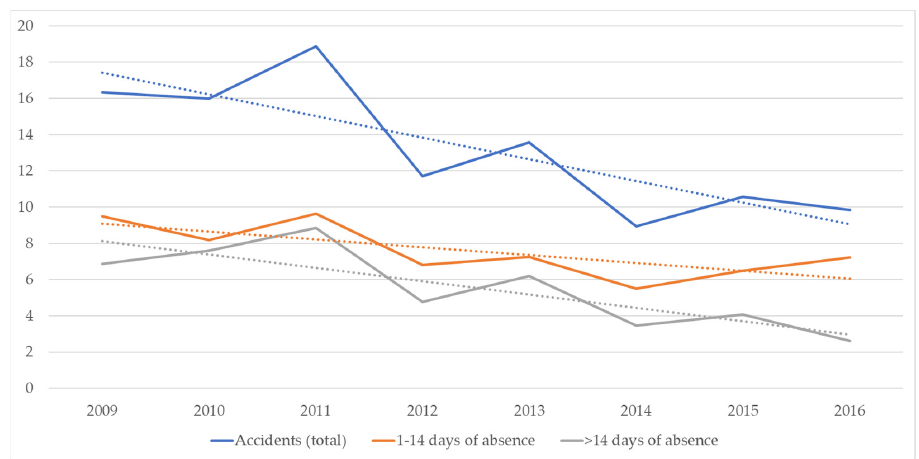
Figure 4. Incidence rates in development of building projects/construction of residential and non- residential buildings. Based on data from [17–24,27].